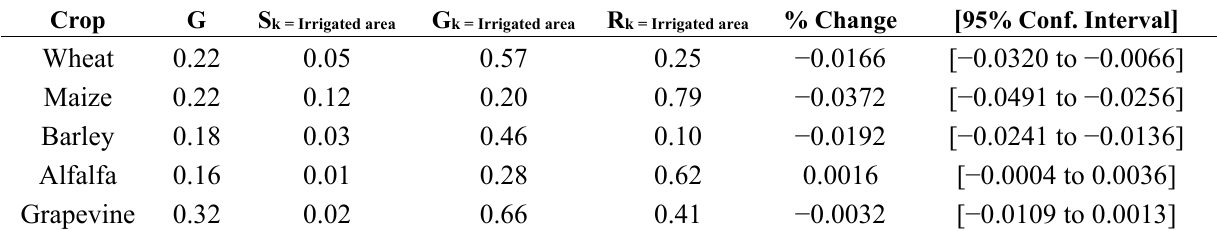
Table 5. Gini decomposition for irrigated area by